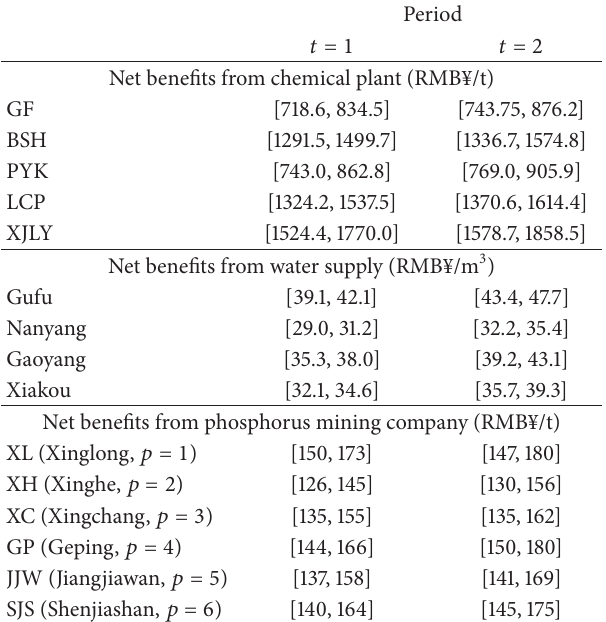
Table 1: Net benefits from each